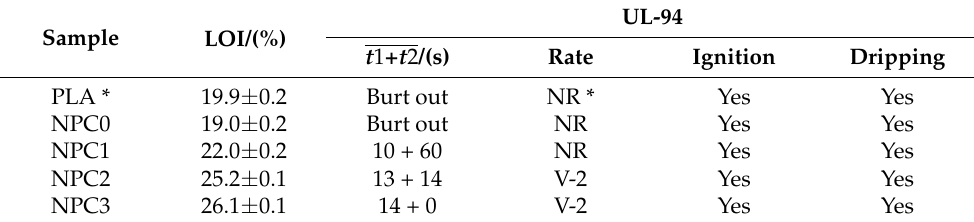
Table 4. Results from LOI and UL-94 tests for PLA-OCC biocomposites.